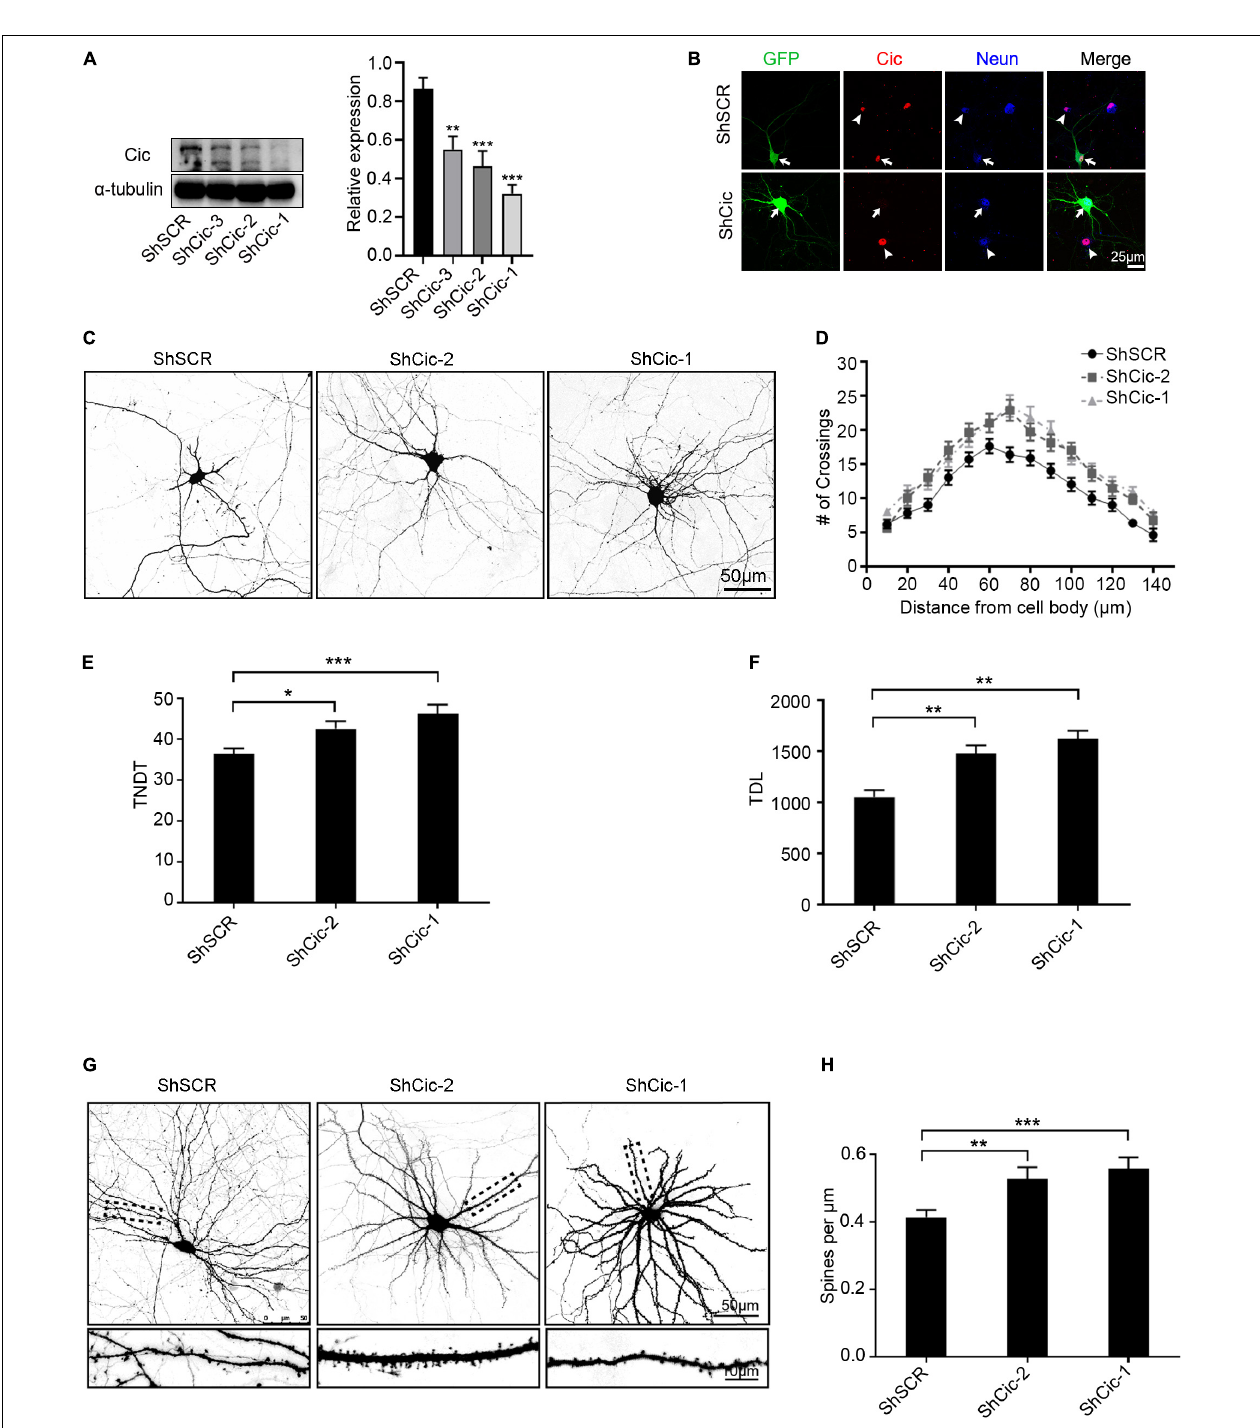
FIGURE 2 | Knockdown of Cic reveals roles in dendrite morphogenesis and the growth of dendritic spines. (A) Knockdown of Cic by lenti-shRNA infection of hippocampal neurons cultured in vitro from DIV 6–7 for 6–7 days was confirmed by WB. The right panel shows quantification of WB. (B) Hippocampal neurons cultured in vitro were transfected on DIV 7 for 6 days with either scramble ShSCR-GFP or ShRNA against Cic. Afterward, the cells were stained with an antibody against Cic, the arrow indicates transfected neurons, and the arrowhead indicates non-transfected cells. (C) Representative images of hippocampal neurons transfected at DIV6-7 with ShSCR, ShCic-1 or ShCic-2 for 6–7 days. (D) Sholl analysis of neurons transfected with ShSCR, ShCic-1 or ShCic-2 (ShSCR: n = 52; ShCic-1: n = 52; ShCic-2: n = 52). (E,F) TNDT and TDL of neurons after Cic knockdown (ShSCR: n = 52; ShCic-1: n = 52; ShCic-2: n = 52). (G) Representative images of neurons transfected on DIV 7 with ShSCR, ShCic-1 or ShCic-2 for 14 days. (H) Quantification of dendritic spine densities (ShSCR: n = 52; ShCic-1: n = 52; ShCic-2: n = 52). Data are shown as the mean ± SE and are representative of n = 3 independent experiments. *** p < 0.001; ** p < 0.01; * p < 0.05.